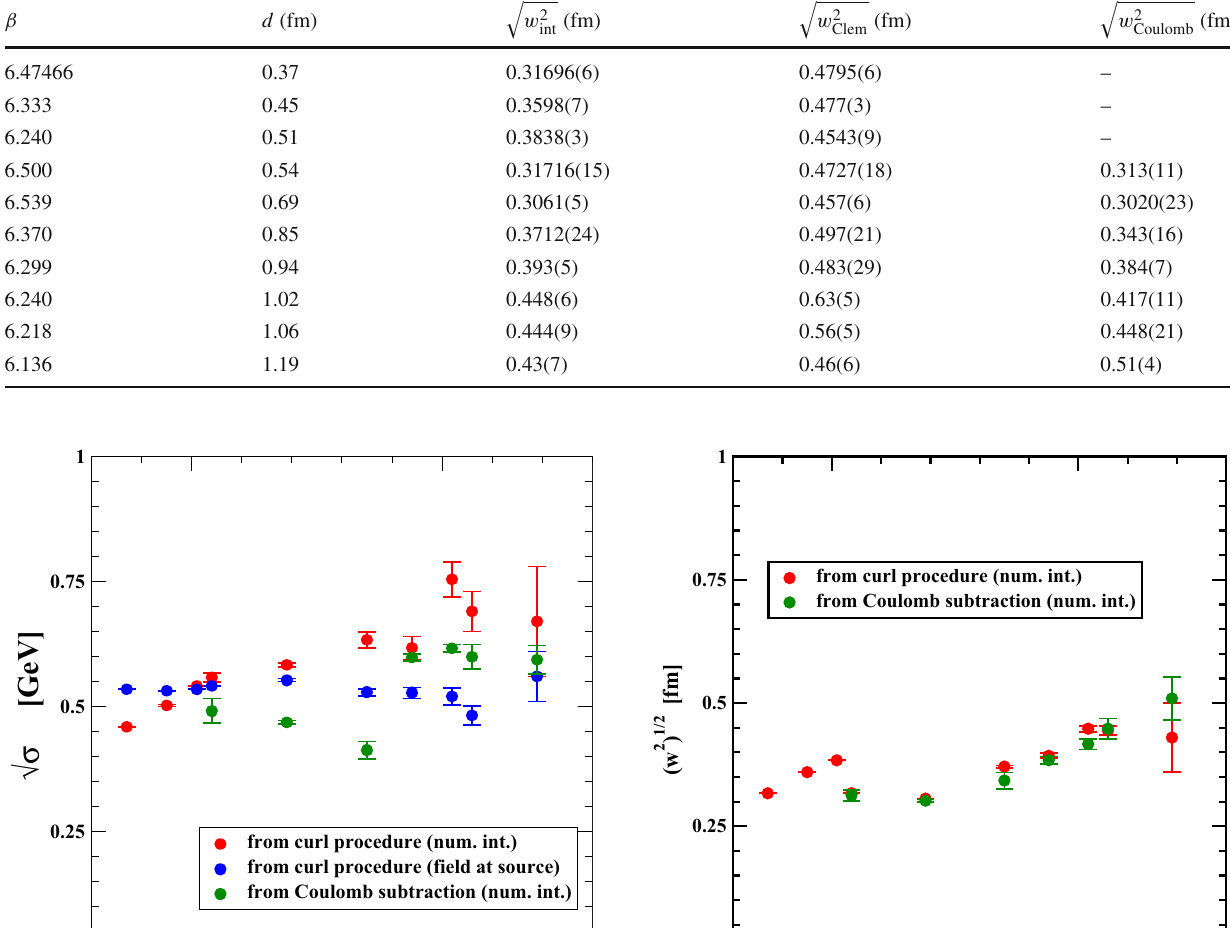
Table 5 The flux tube width estimated using the non-perturbative field from the curl procedure by employing different methods (from left to right: numerical integration of the field, analytical integration of the Clem function with parameters given in Table 3). In the last column